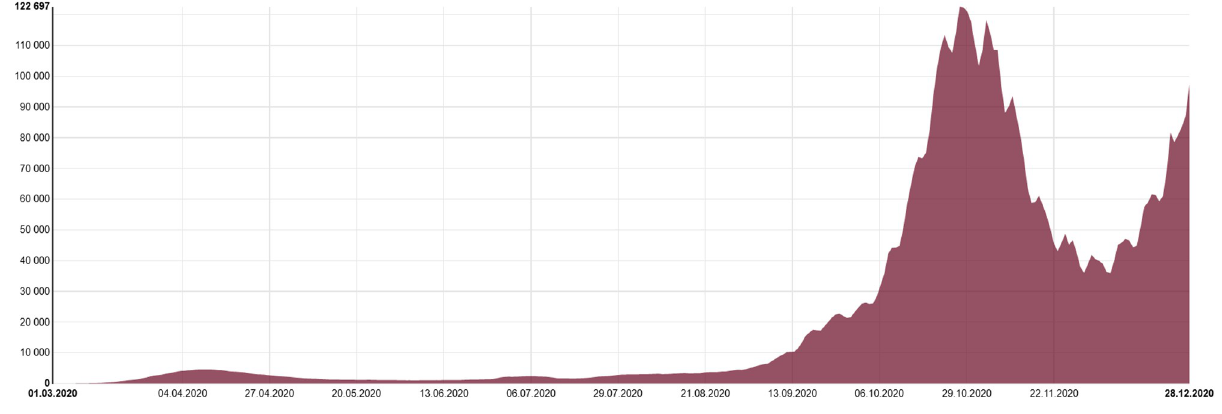
Fig 3. The trend profile of the COVID-19 active cases in the Czech Republic.